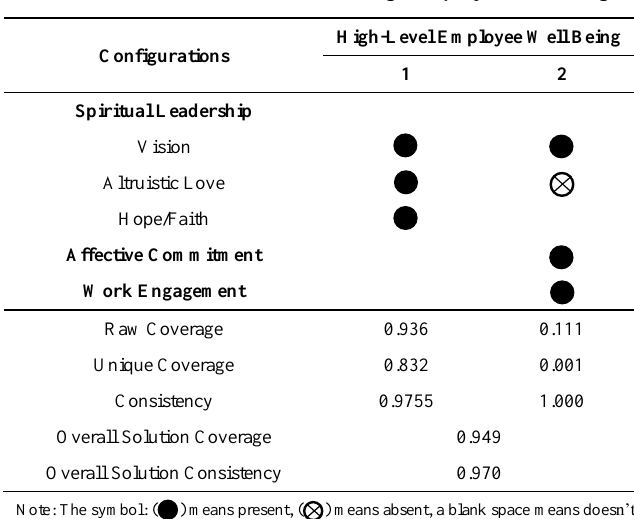
Table 6. Intermediate solutions for high employee well-being